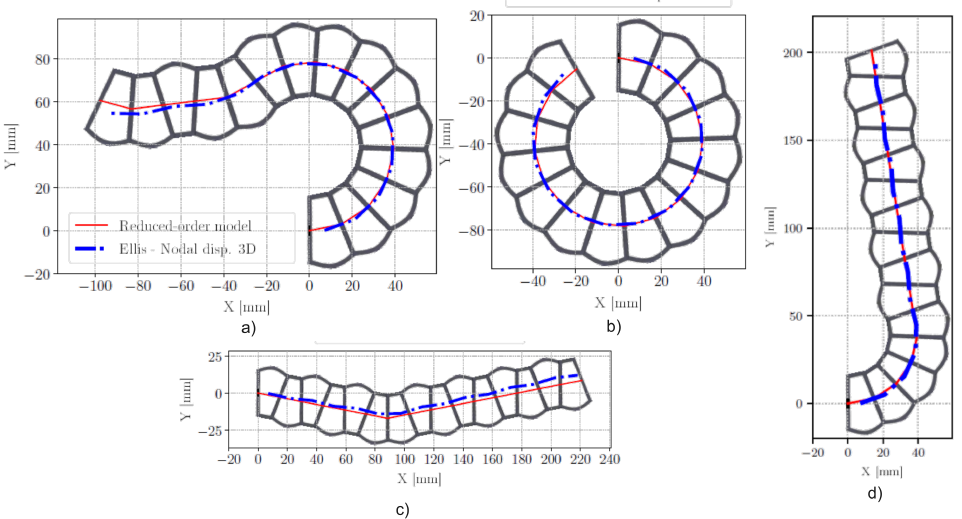
Figure 8. Visual representations of the resulting deformed bending actuators for each case described in Table 6. ( a ) Min horizontal, ( b ) min radius, ( c ) max horizontal, ( d ) max vertical. It should be noted that the result for the simple linear extension case ( d ) has an unexpected shape with a “kink” in the middle. This results from the fixed unit’s mounting angle, which is corrected by the mid-span “kink”.